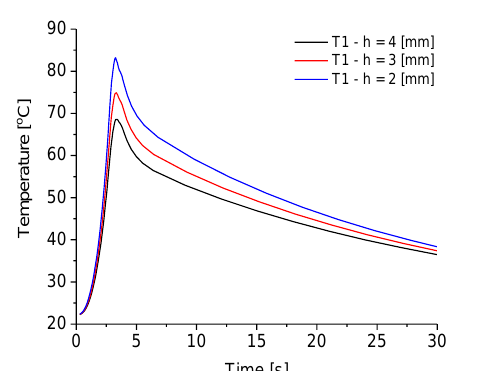
Fig. 7. Temperature changes depending upon the height of the test sample